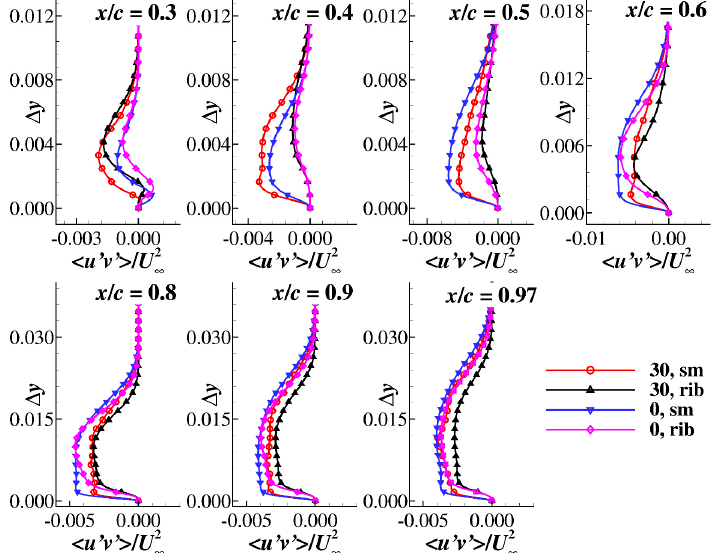
′ ′ ′ ′ at the seven locations. at the seven locations.